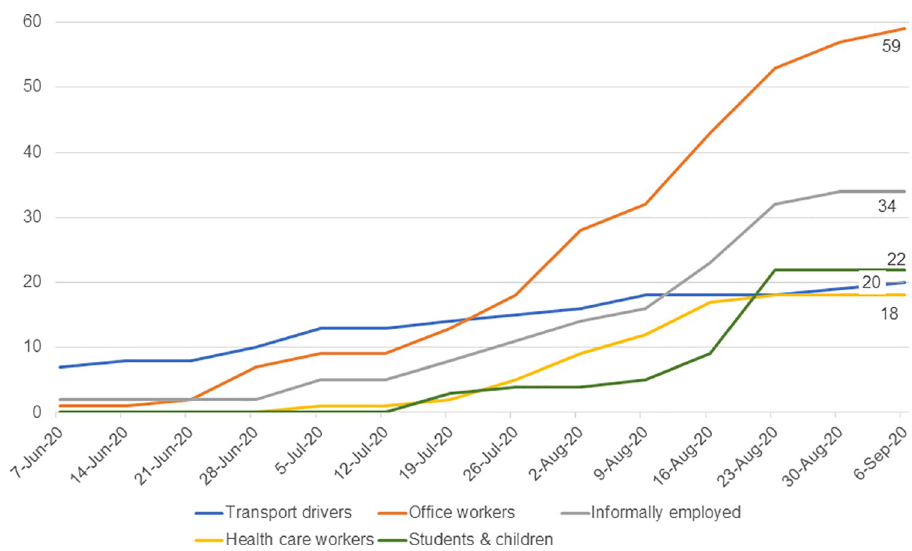
Fig 2. Weekly occupation trends among cases, FFX study, Kisumu, Kenya (June-October 2020).